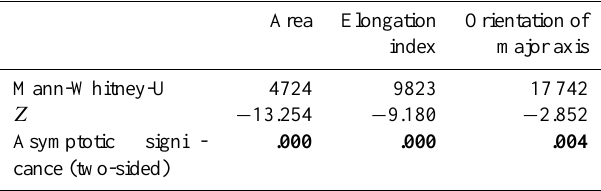
Table 6. Results of the rank-based Mann-Whitney-U test for mor- phometric differences between lakes on Yedoma uplands and sin- gle basins . Significant differences between the two subgroups were found for all three morphometric